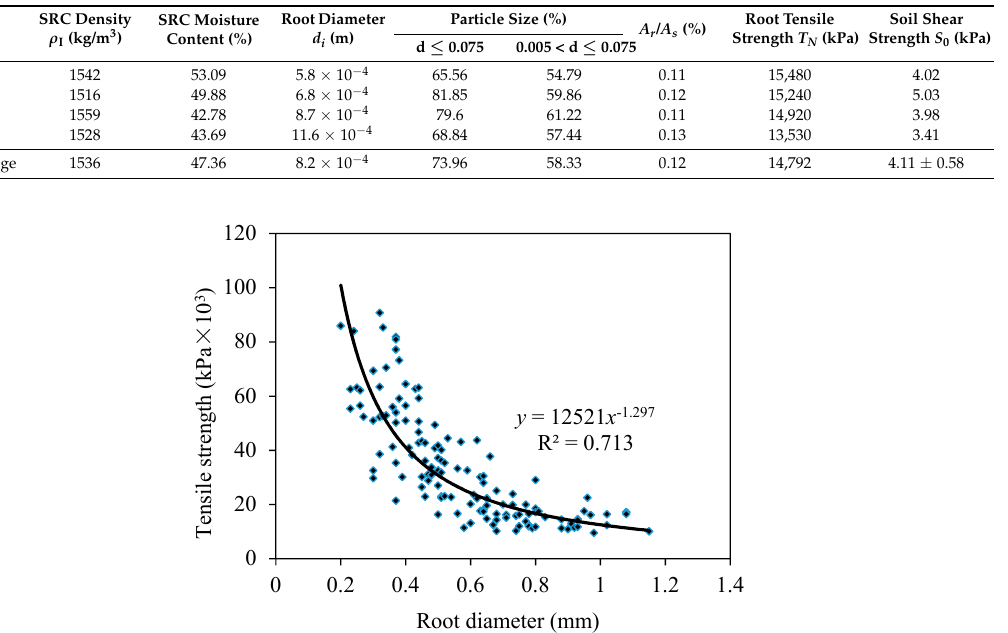
Table 2. Physical parameters of soil-root composite (SRC), soil, and roots in the undisturbed samples.